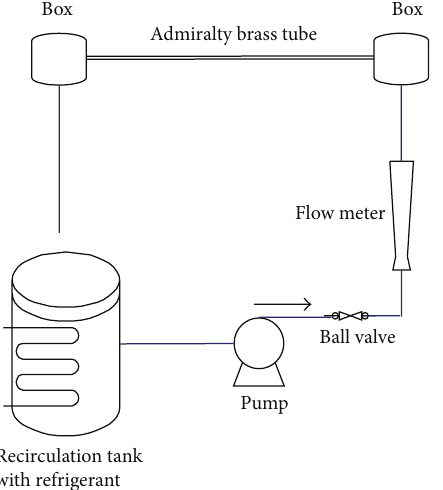
Figure 1: Prototype condenser and diagram of the circuit.